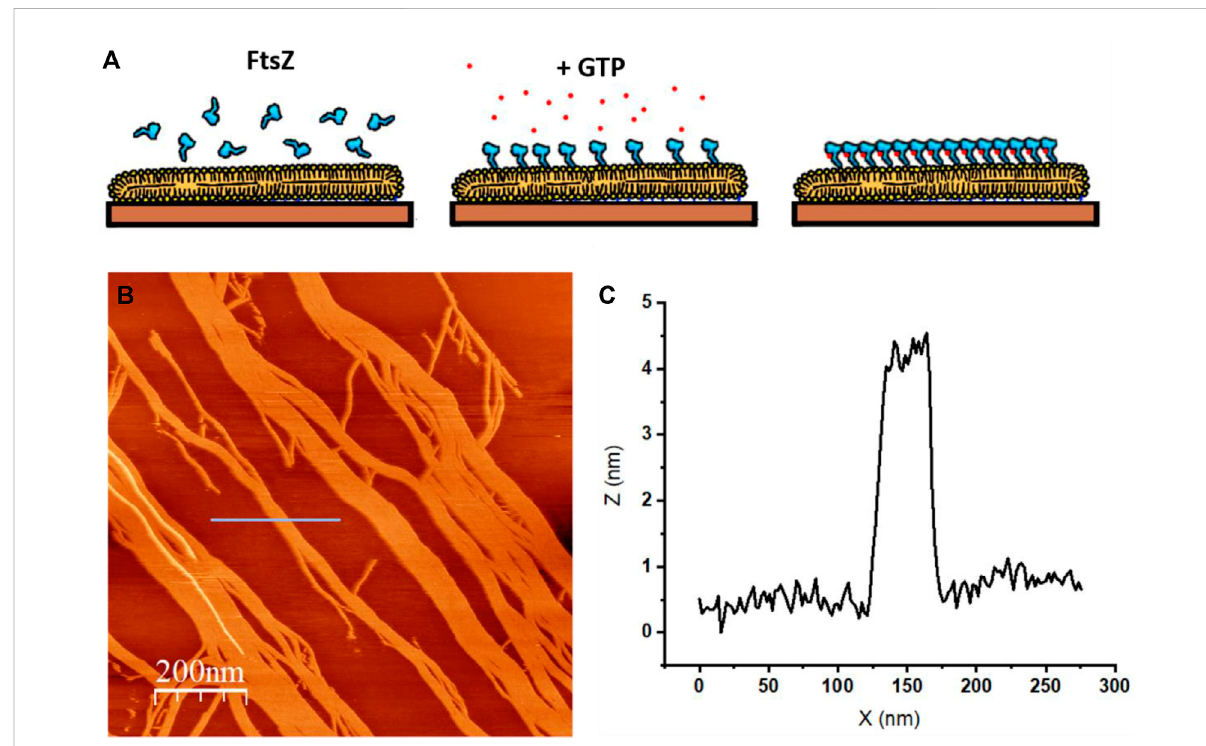
AFM topographic image of protein seggregation in an SLB. (A) The protein is bacterial cytoskeletal protein FtsZ covalently attached to a lipid bilayer as described in (Márquez et al., 2019). FtsZ protein forms fi laments in the presence of GTP (B) Topographic image that shows the fi laments formed on top of the SLB upon GTP addition. The colors represent differences in height: lighter regions protrude from the surface more than darker regions (unpublished image from Velez ’ s lab.) (C) Pro fi le under the blue line in (B) that shows the height of the fi